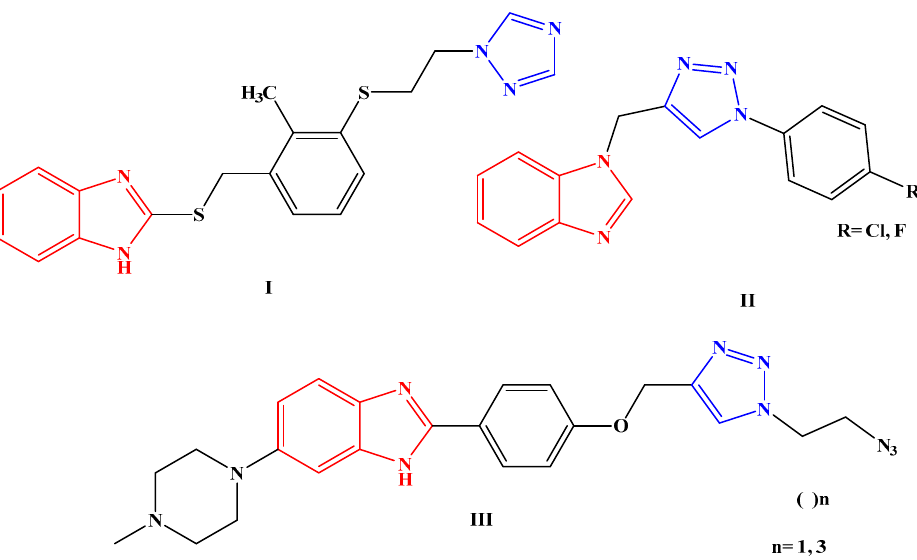
Figure 1. Hybrid molecules bearing benzimidazole and triazole moieties I–III as antibacterial agents.